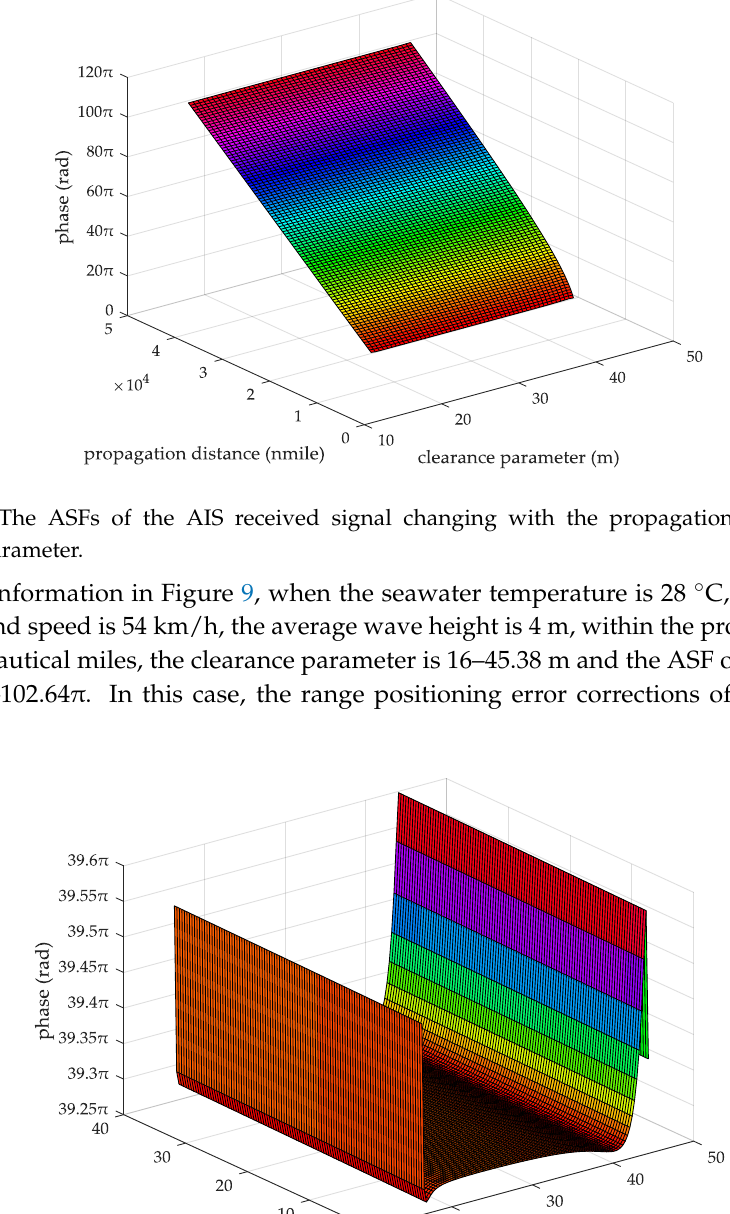
Figure 11. The ASFs of the AIS received signal changing with the sea salinity and the clearance parameter.